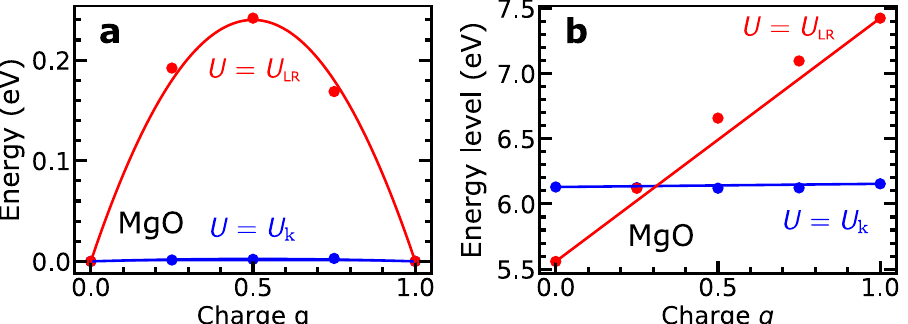
Fig. 6 Piecewise linearity of different schemes for the determination of U . a Deviation from the piecewise linearity of the total energy and b dependence of the defect level on the charge q , for the self-trapped hole in MgO. Results for U k and U LR are compared. The solid lines are a guide to the eye.